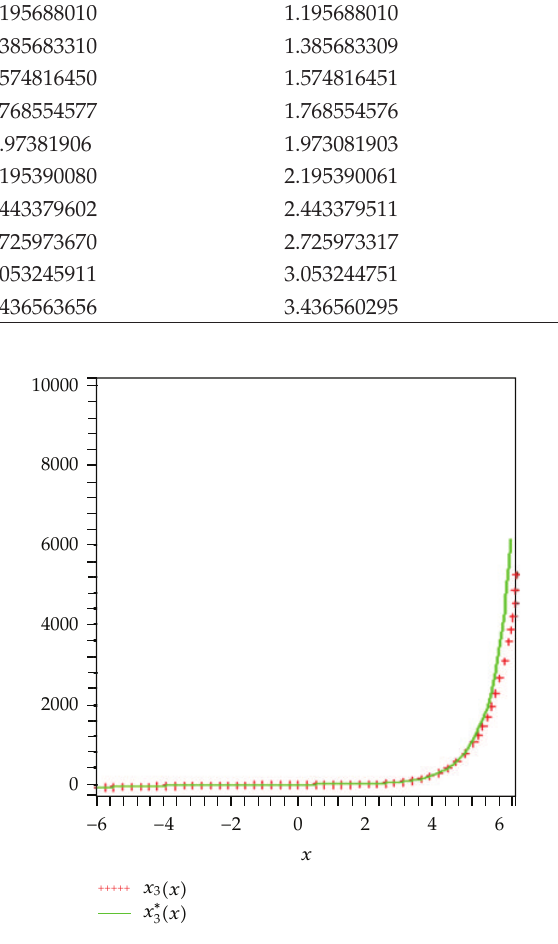
(cid:3) x (cid:4) variational 3